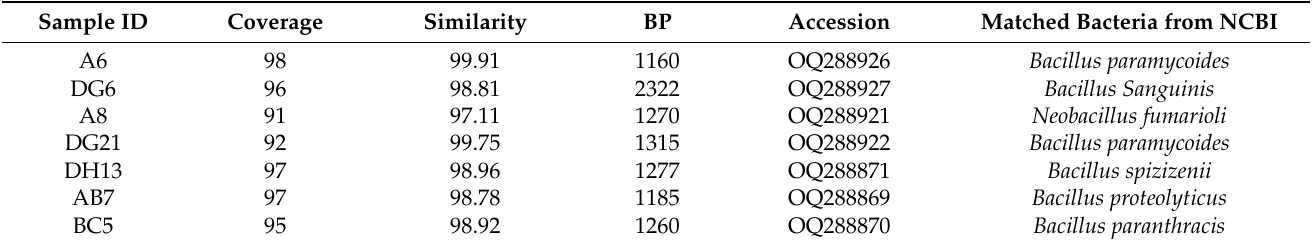
Figure 4. Phylogenetic analysis based on partial 16S rRNA sequences of the bacterial isolates and related Bacillus spp. The tree reconstruction was generated using the Neighbor-Joining method. Table 5. Culture-based and molecular identification of Bacillus strains using 16S rRNA gene sequences obtained from waste